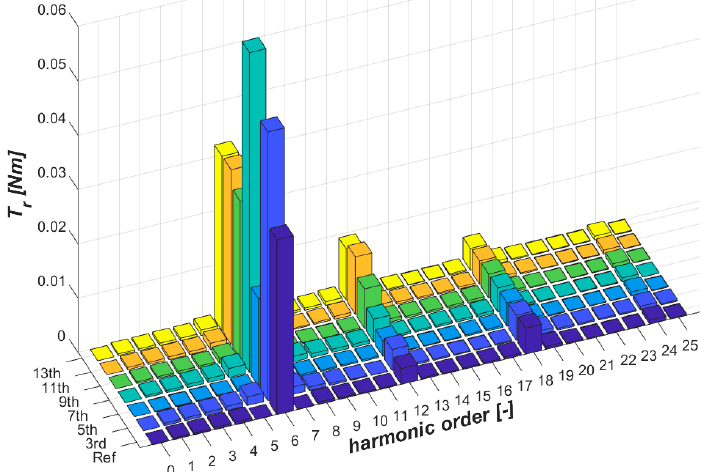
Figure 4. Harmonic content of torque ripple for odd harmonic injection.